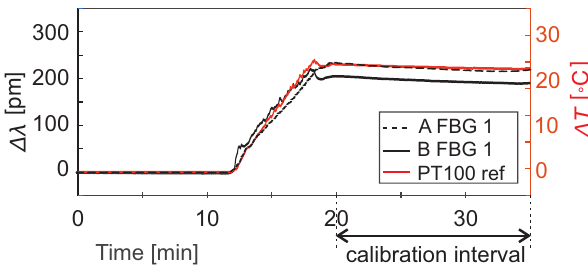
Figure 5. An example of the calibration curves for two FBG sensors: Each sensor is inscribed in a fiber with a different coating. The sensor A FBG 1 has a teflon coating; the sensor B FBG 1 has a PVC